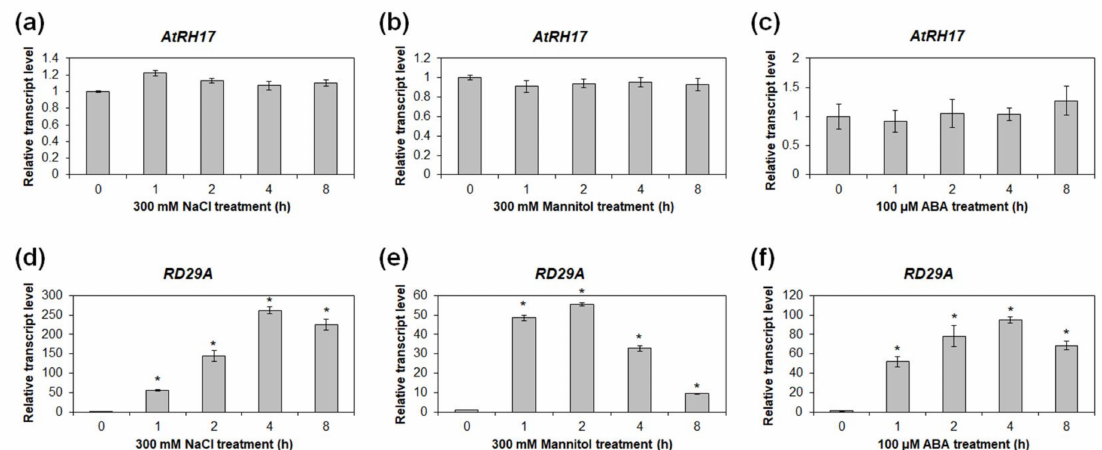
Figure 4. Expression analysis of AtRH17 under osmotic-stress conditions. ( a , d ) Quantitative RT-PCR analysis of AtRH17 ( a ) and RD29A ( d ) under 300 mM NaCl treatment for 0, 1, 2, 4, and 8 h. ( b , e ) Quantitative RT-PCR analysis of AtRH17 ( b ) and RD29A ( e ) under 300 mM mannitol treatment for 0, 1, 2, 4, and 8 h. ( c , f ) Quantitative RT-PCR analysis of AtRH17 ( c ) and RD29A ( f ) under 100 µ M abscisic acid (ABA) treatment for 0, 1, 2, 4, and 8 h. RD29A was used as a control for NaCl, mannitol, and ABA treatments. GAPc was used as an internal control. Transcript levels at 0 h were set as 1. Three independent reactions were performed for each technical replicate. Two technical replicates were performed for each biological replicate. At least two biological replicates showed similar results, with one shown here. Error bars represent standard deviation ( n = 6 reactions) and * indicate t -test p < 0.05.